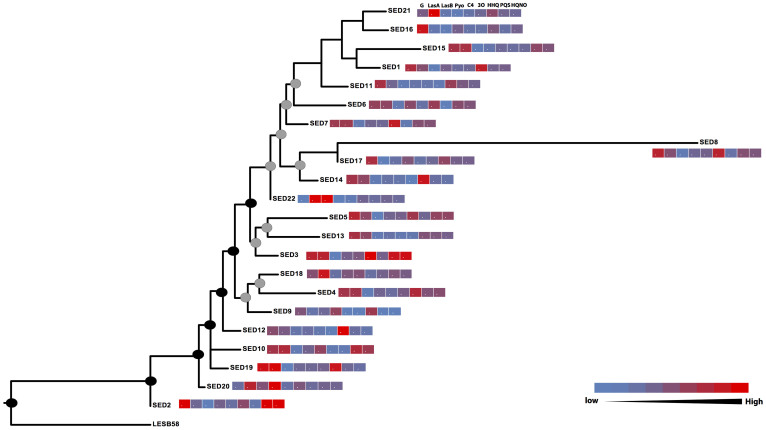
Maximum likelihood phylogeny based on SNP typing of the 22 sequenced isolates against LESB58.Nodes obtaining >95% bootstrap support (black circles) and >75% bootstrap support (grey) are indicated on the tree. The heatmaps accompanying each taxa represent the levels of production of each phenotype relative to the reference PAO1 strain and are indicated above SED21. Abbreviations: G (growth), LasA (LasA protease), LasB (protease), Pyo (pyocyanin), C4 (C4-HSL), 3O (3O-C12-HSL).